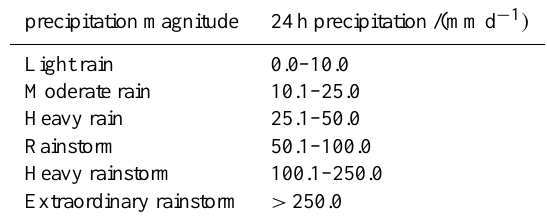
Table 5. Precipitation magnitude